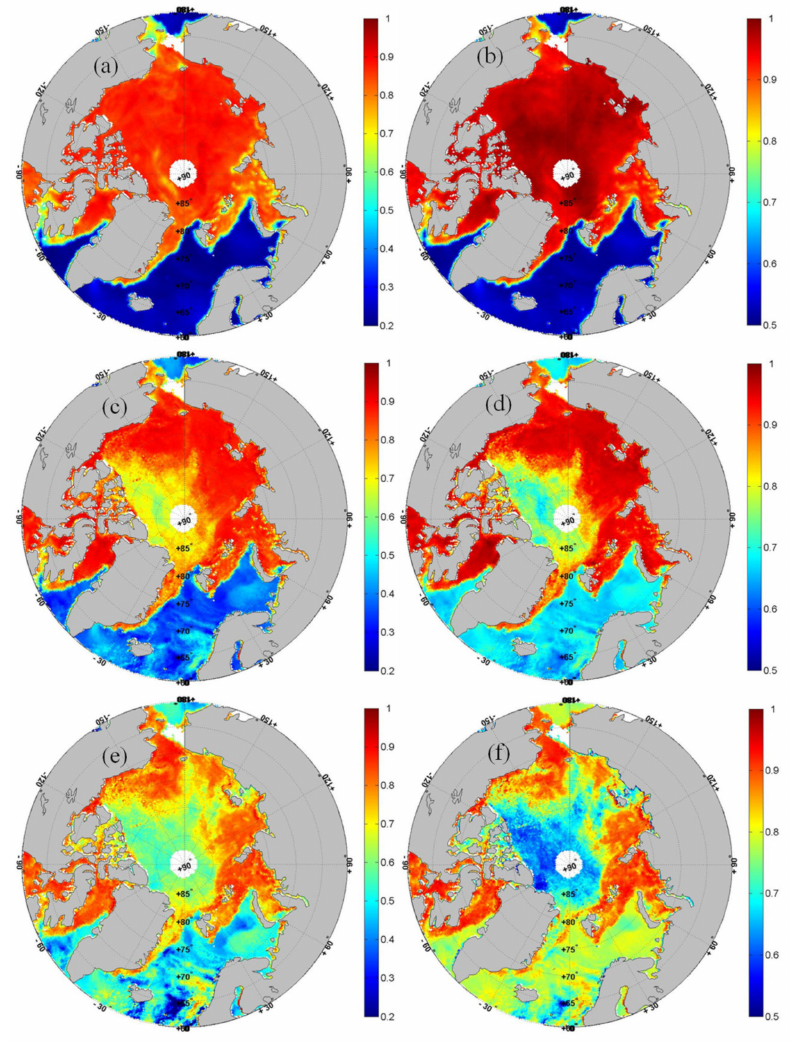
Figure 1. Fields of daily averaged emissivity of the Arctic Ocean on 1 January 2020: ( a ) 6.9 GHz, H; ( b ) 6.9 GHz, V; ( c ) 36.5 GHz, H; ( d ) 36.5 GHz, V; ( e ) 89 GHz, H; ( f ) 89 GHz,